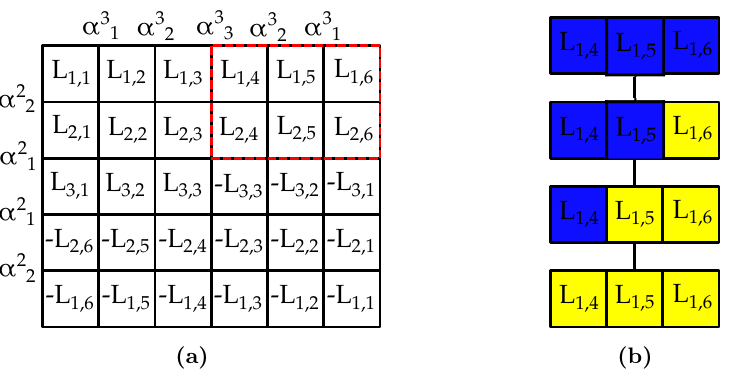
Figure 39. In (a) is the weight diagram of the ( 5 ; 6 ) representation of Sp(2) (cid:2) Sp(3). We can see that, because the representation is self-conjugate, that the signs associated to L i;j for i; j = 1 ; (cid:1) (cid:1) (cid:1) ;